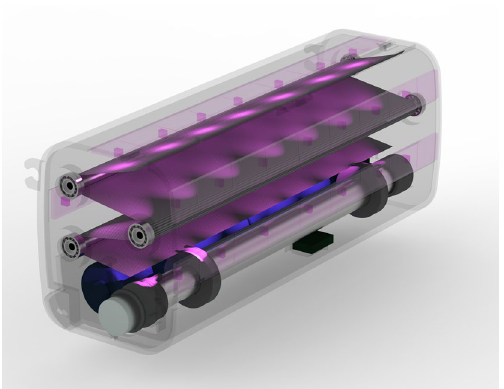
Figure 2. Schematic of UVC light exposure on the face covering inside ARMOR.